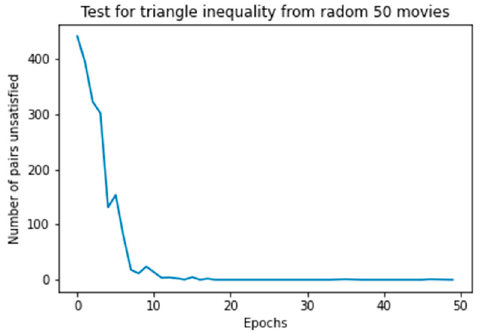
Figure 4. The triangle inequality check test. We sampled 50 points randomly at each epoch and checked all pairs were satisfied triangle inequality. The y -axis is the number of unsatisfied pairs. The x -axis is the number of each epoch.